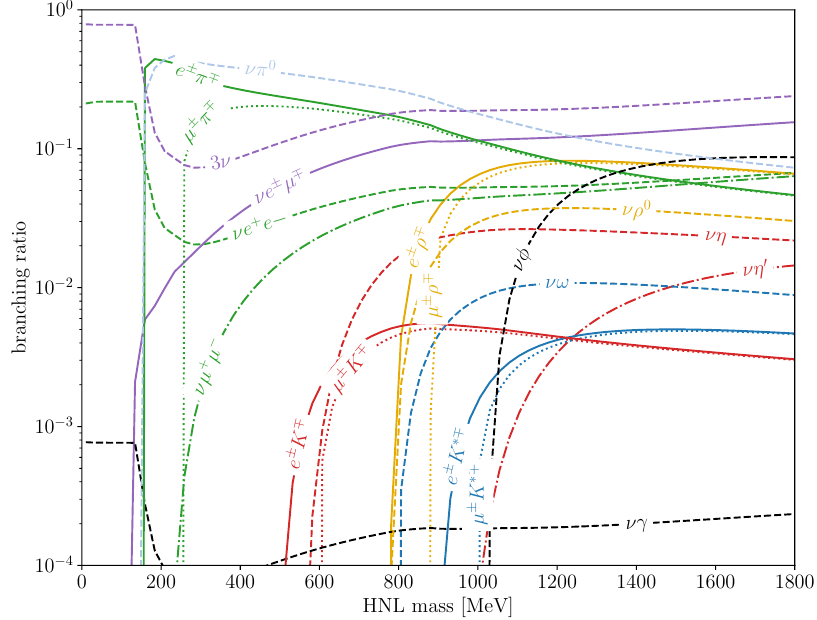
Figure 8 . Branching ratios of HNL decay modes as a function of mass. We have assumed flavor- universal mixing, i.e. | U